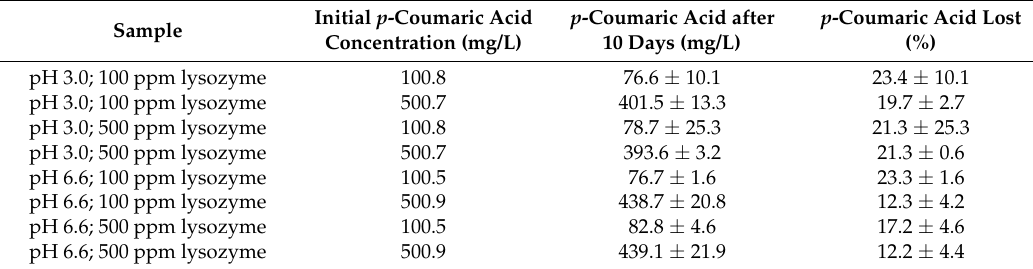
Table 3. Changes in p -coumaric acid at different concentrations and pH in model trials.